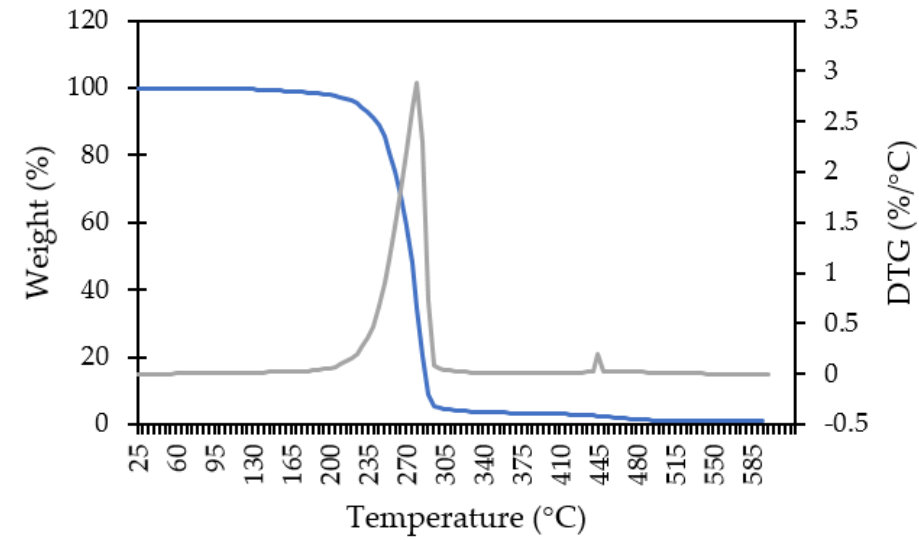
Figure 8. Thermogravimetric analysis of PLA composite with 1.5% CNC and 1.5% zinc oxide under oxidative degradation (70% air, 30%